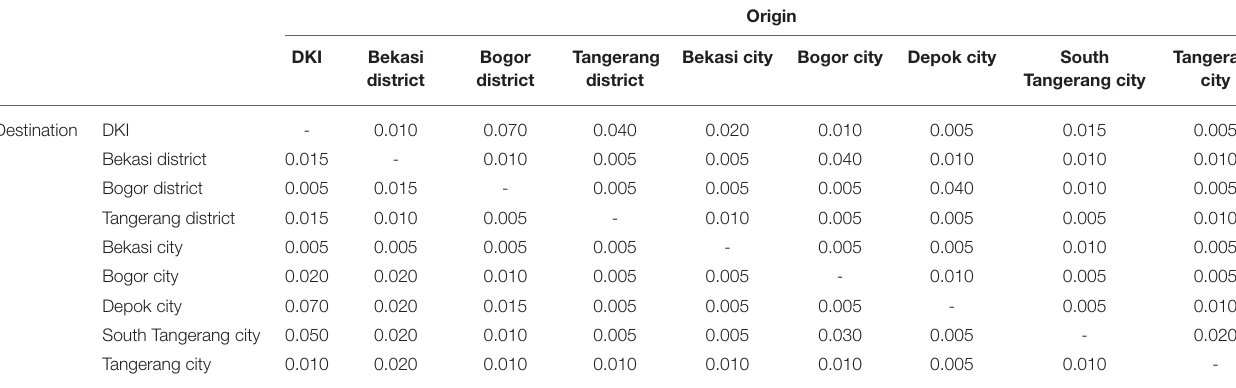
TABLE 3 | Estimated OD matrix in Jabodetabek (district/city scale).